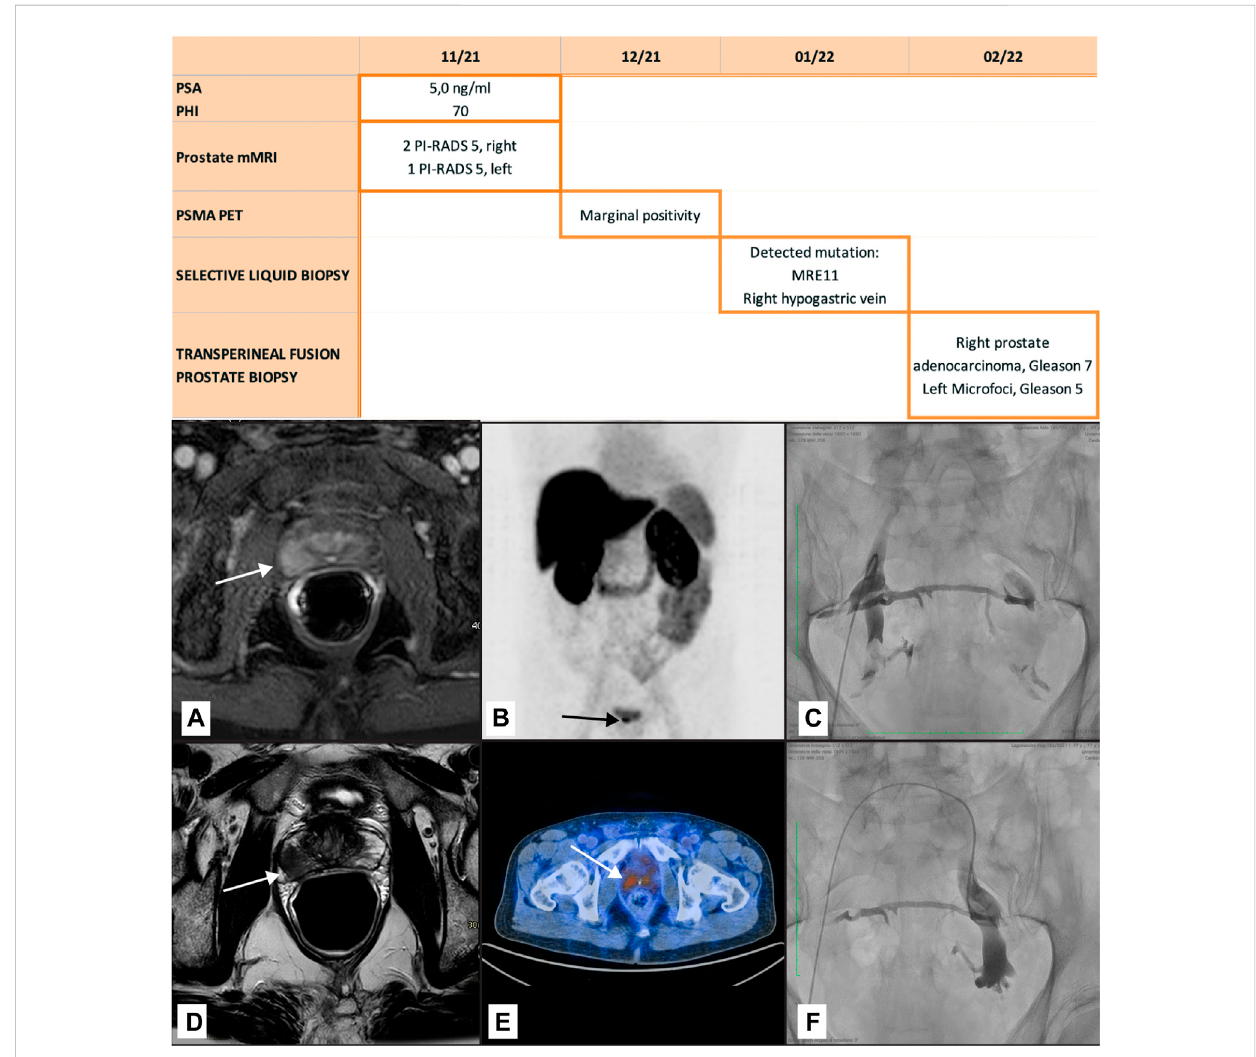
FIGURE 2 Prostateadenocarcinoma.Thetableshowsthetestsperfomed.The fi guresshowthemultiparametricMRIdetectingthetumor (B,C) ,thePSMAwith marginal positivity (D) , and right transfemoral catheterization of the hypogastric veins for ctDNA sampling (E, F) with the veins opaci fi ed by injection of contrast medium. The two sides are connected by the pelvic venous